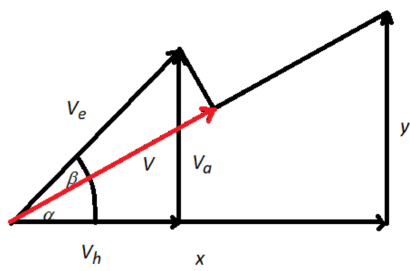
Figure 5. Drone speed (source: self-edited